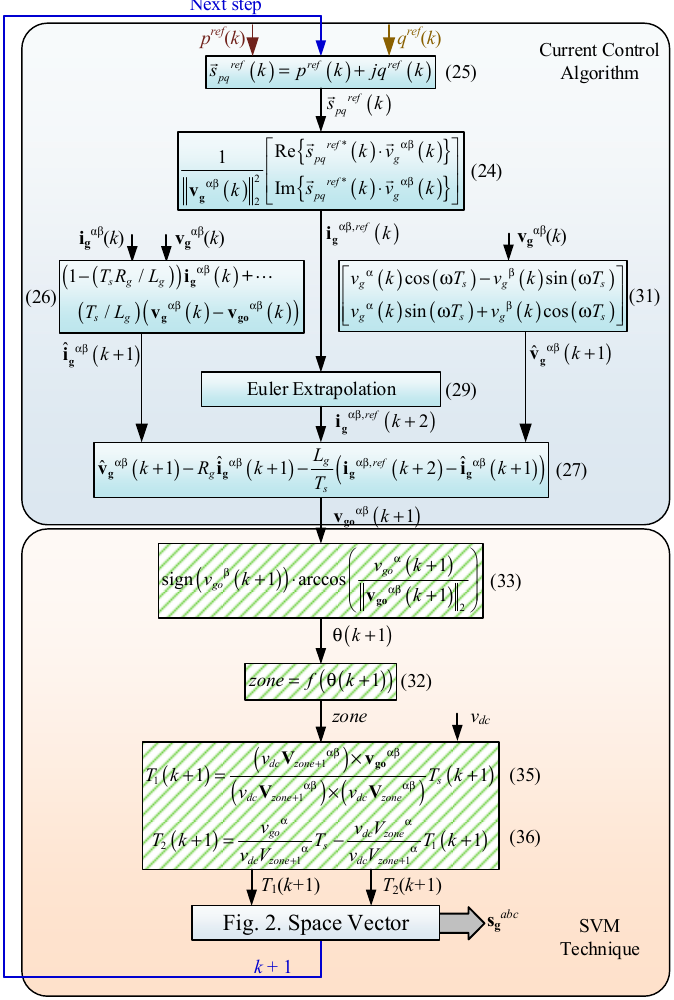
Figure 3. Proposed predictive control.